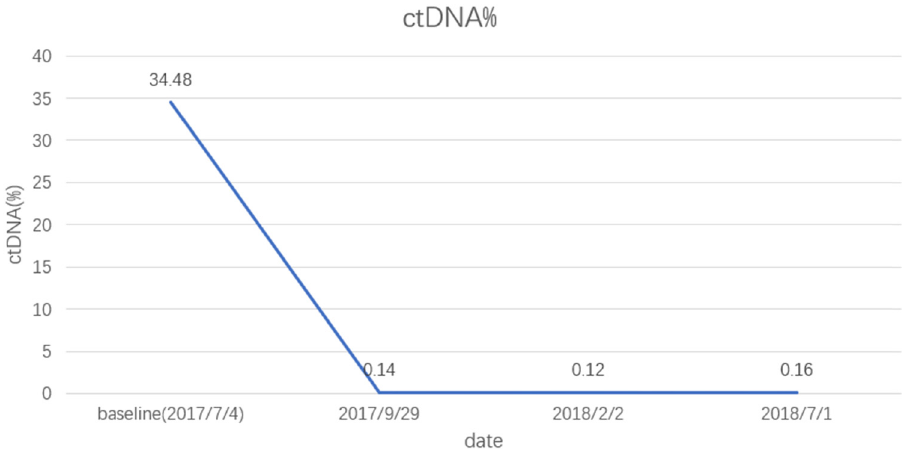
Figure 4: Variation of ctDNA abundance in the peripheral